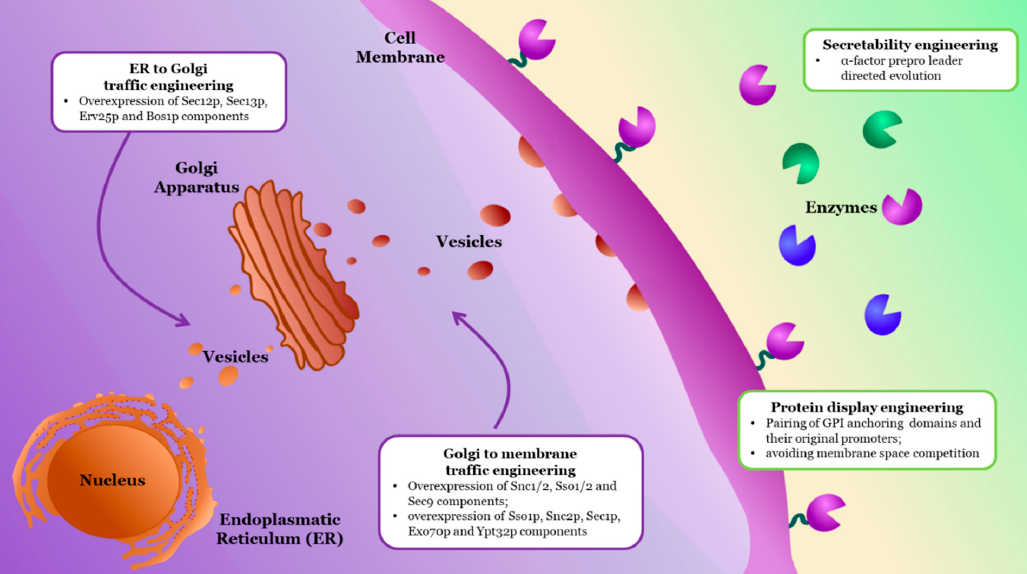
Figure 3. Strategies for the improvement of enzyme functional expression in yeasts. This figure illustrates the approaches discussed in further detail in the text. Typical targets for vesicle traffic engineering are listed within the purple (intracellular) area, whereas the green (extracellular) region shows the strategies employed to improve enzyme display and secretion.